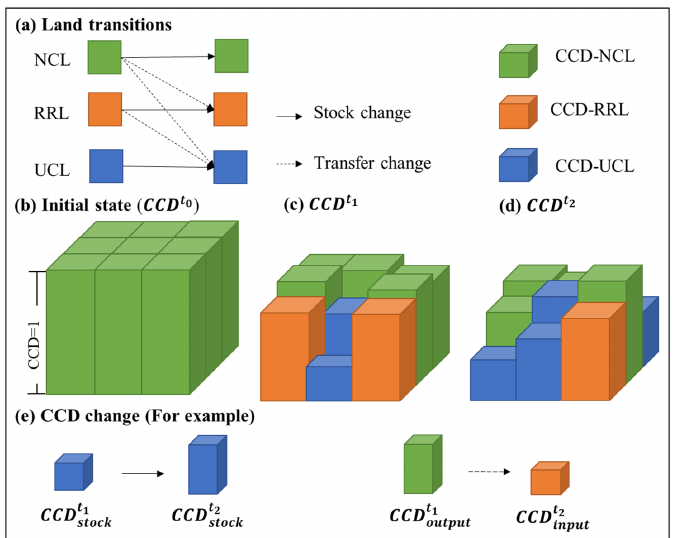
Figure 2. The conceptual pixel ‐ wise remote sensing ‐ based model for CCD quantification during land transitions.